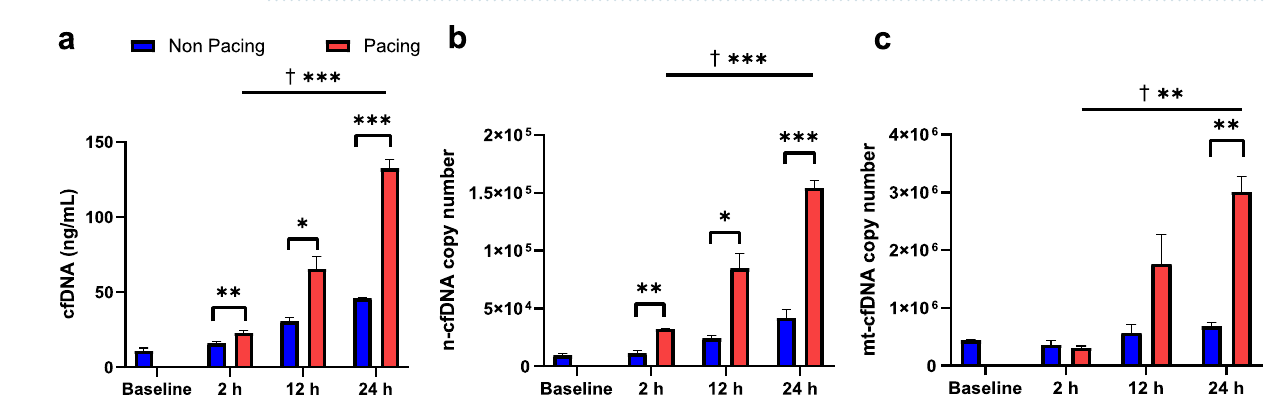
Figure 3. Total cfDNA, n-cfDNA, and mt-cfDNA in in vitro AF mimicking model. ( a ) Total cfDNA, ( b ) n-cfDNA copy number, ( c ) mt-cfDNA copy number in an in vitro tachycardia pacing model (n = 3 in each pacing duration). Absolute n-cfDNA and mt-cfDNA copy numbers were calculated using qPCR, using the created standard curves. Unpaired t test was performed. ANOVA test were followed by post-hoc Tukey for a in comparison among pacing groups (†). * p < 0.05, ** p < 0.01, *** p < 0.001, † in comparison among pacing